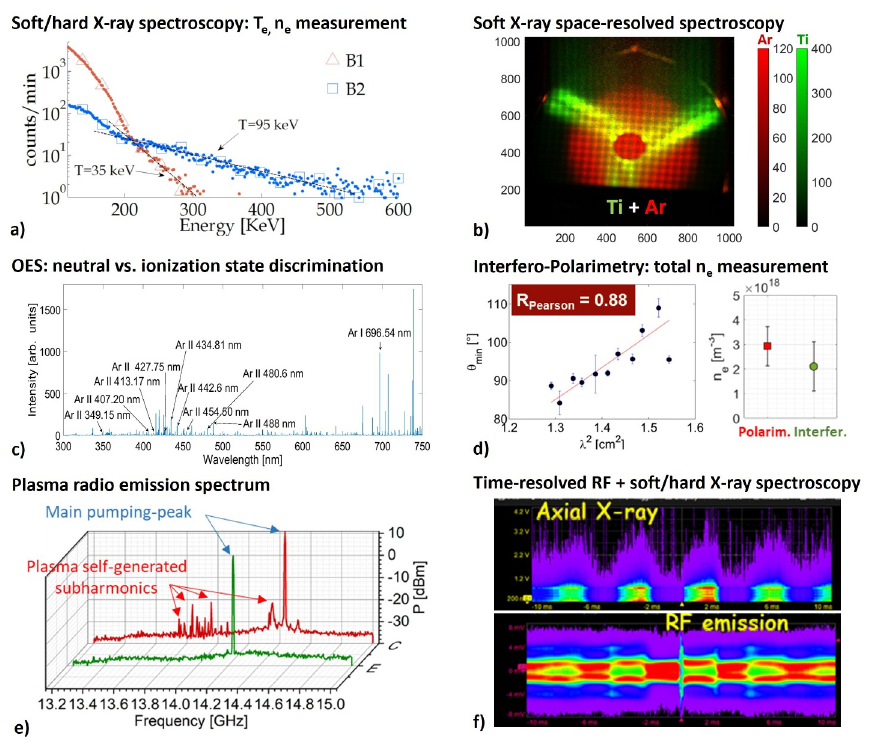
Figure 2. Overview of the main experimental results obtained through the multi-diagnostic system. a) Volumetric hard X-ray spectrum for two magnetic field profiles; b) Energy-filtered SPhC image of flu- orescence X-rays coming from plasma (Ar) and from chamber walls materials (Ti); c) Optical emission spectrum of an Ar plasma; d) Faraday angle vs. probing wavelength in a polarimetric measurement (left) and total n e measure by microwave interferometer and polarimeter (right); e) Plasma radio emis- sion spectrum in a stable (green) and turbulent regime (red); f) time-resolved RF and hard X-ray spectra.